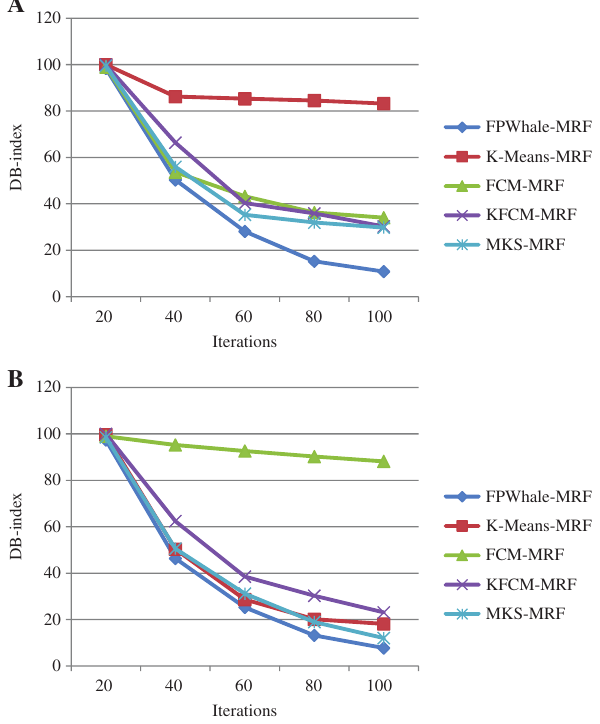
Figure 6: Comparative Analysis Using (A) Dataset 1 and (B) Dataset